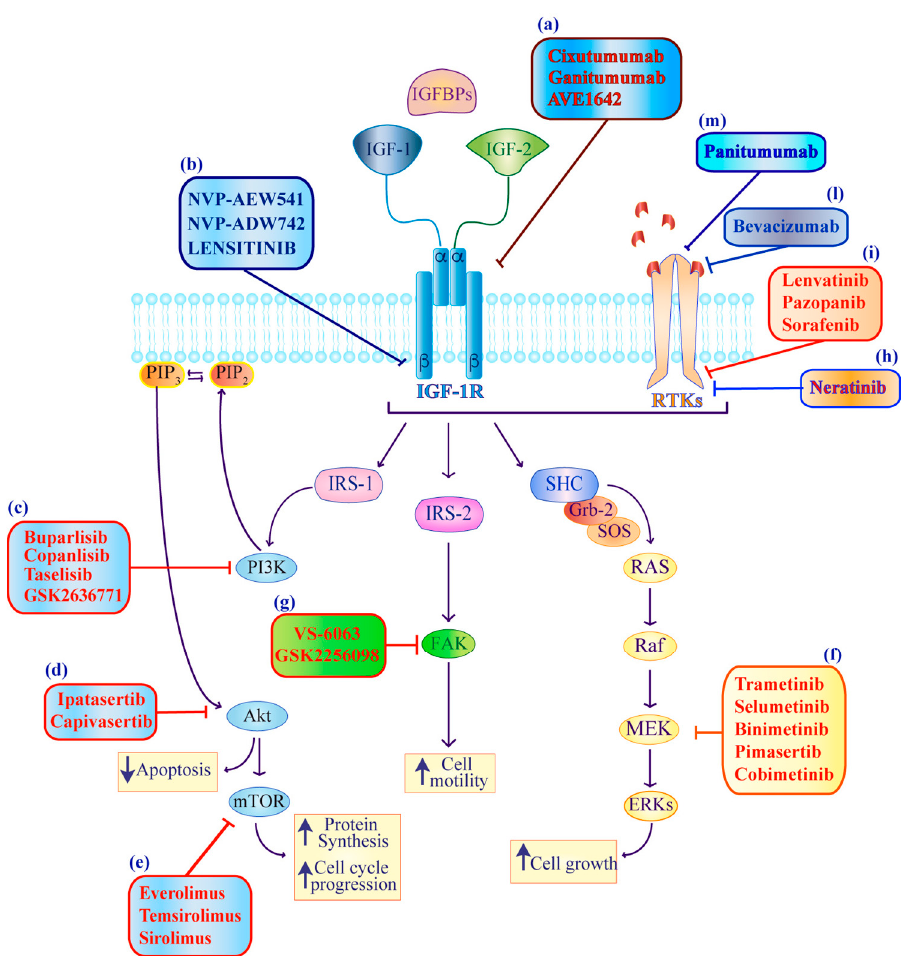
Figure 3. Schematic representation of direct and indirect pharmacological agents targeting the IGF axis that have been investigated in thyroid cancer. IGF-IR direct inhibitors, IGF-IR mAbs ( a ) and IGF-IR TKIs ( b ) reduce IGF downstream signaling. IGF-IR / RTK downstream inhibitors targeting PI3K ( c ), AKT ( d ) and mTOR ( e ) restore apoptosis while blocking protein synthesis and cell cycle progression. MEK ( f ) and FAK ( g ) inhibitors interfere with cell motility, respectively, while EGFR inhibitors ( h ), MK (multi-kinase) inhibitors ( i ) and RTK mAbs ( m ) hinder the cooperation between the IGF-IR and other RTKs.